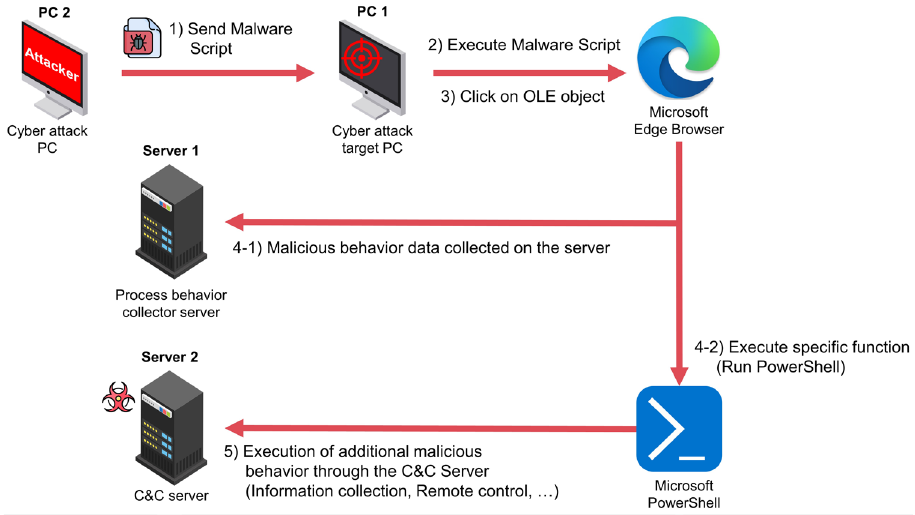
Figure 3. Abnormal behavior collection process.